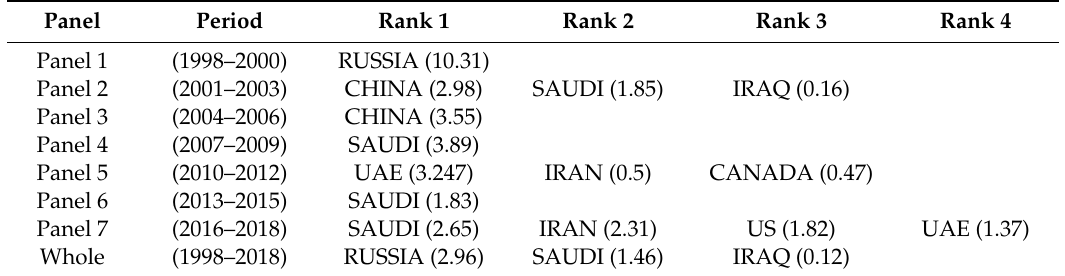
Table 20. Co-move impact rank, based on significant coe ffi cient estimates at the 10% level. Panel Period Rank 1 Rank 2 Rank